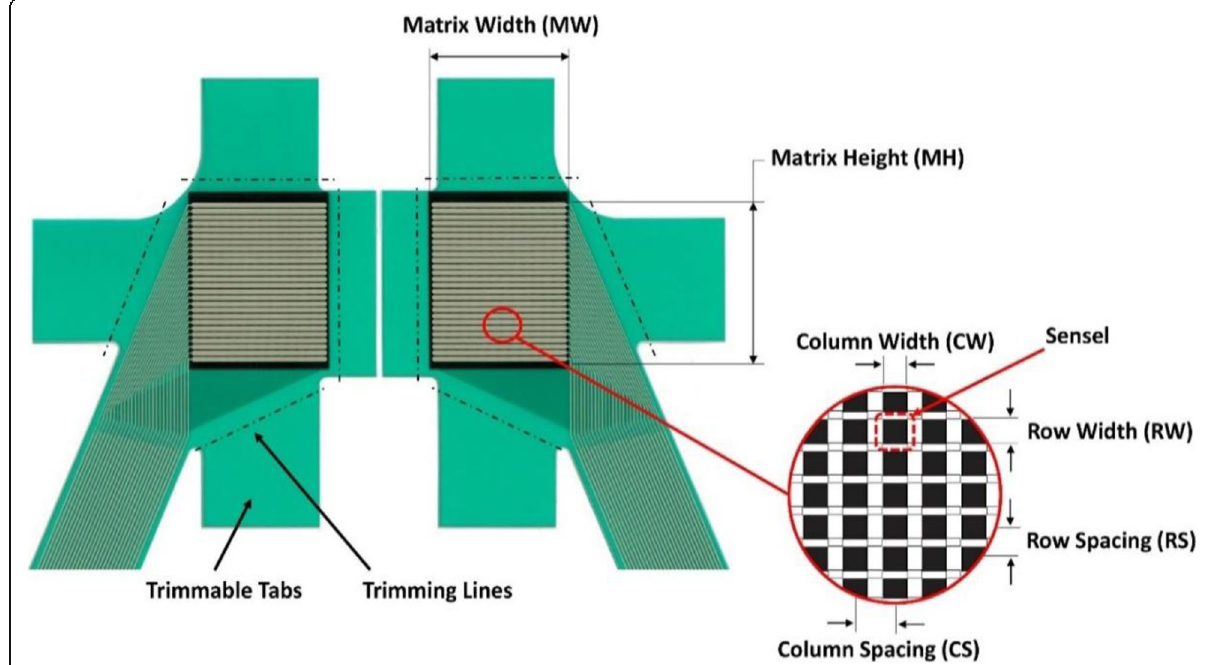
Fig. 5 Tekscan pressure mapping sensor 4000 and a magnified sensing matrix, used for the